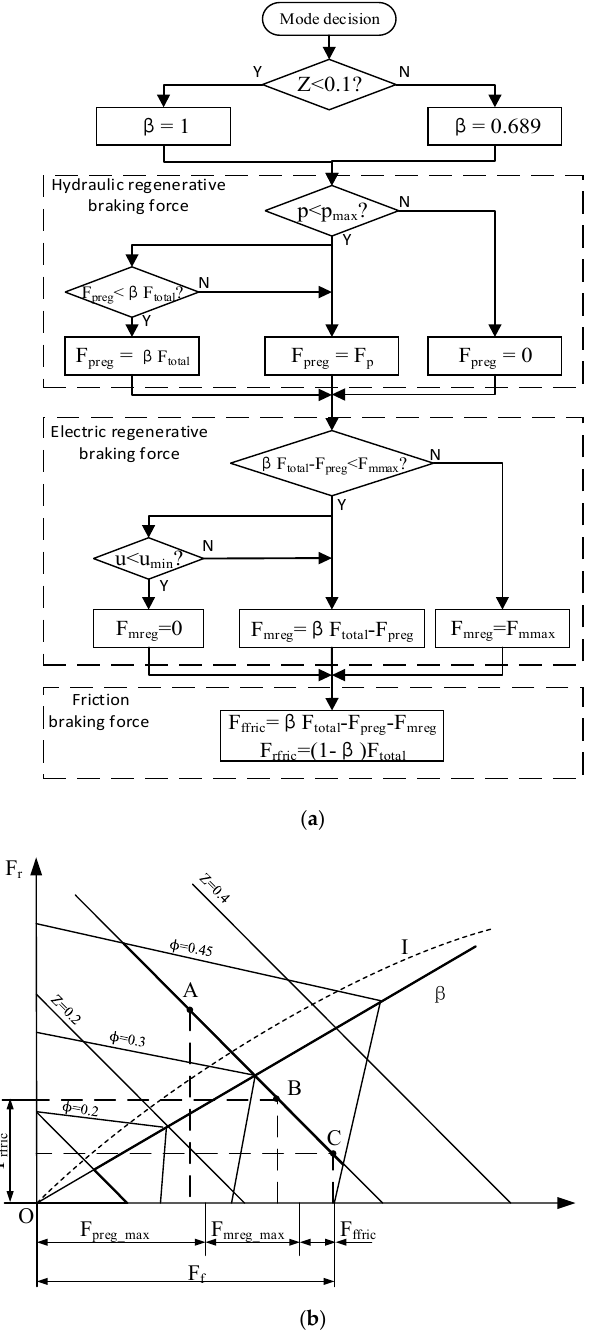
Figure 4. Braking force distribution strategy by following the maximum energy recovery rate. ( a ) Braking force distribution strategy flow chart; ( b ) Braking force distribution curve.